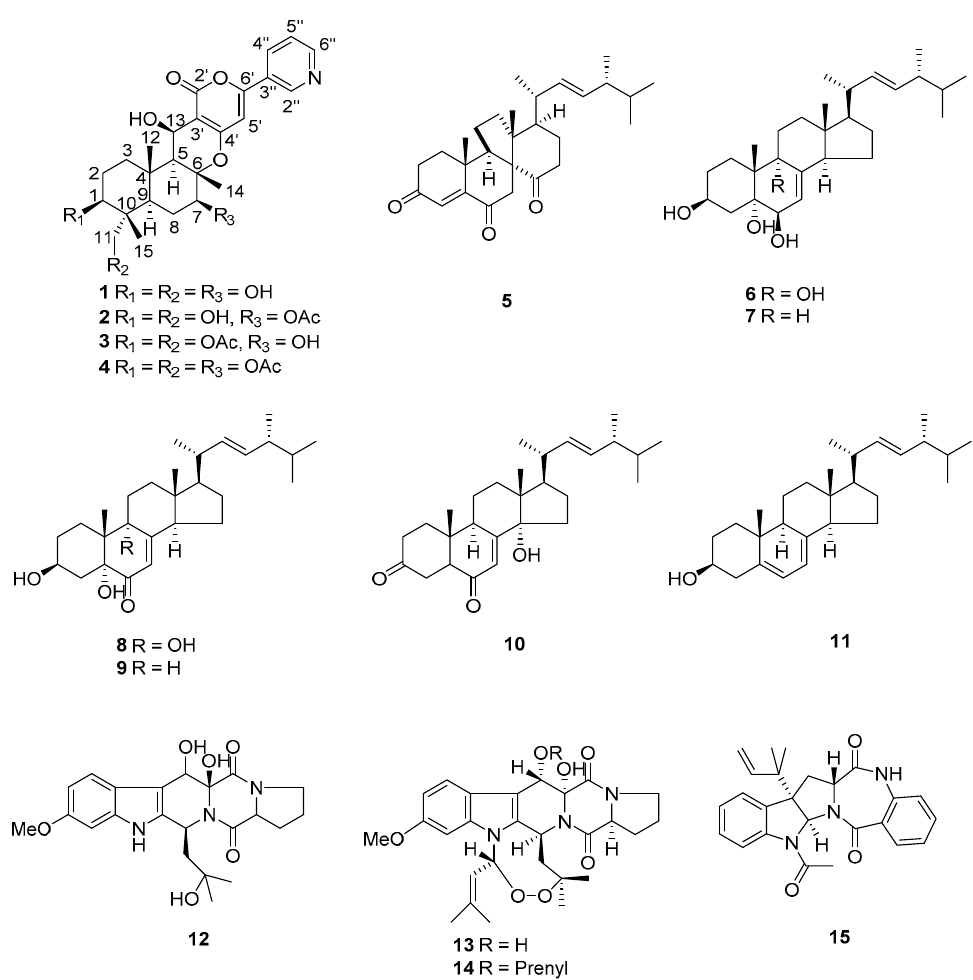
Figure 1. Structures of compounds 1 − 15 .